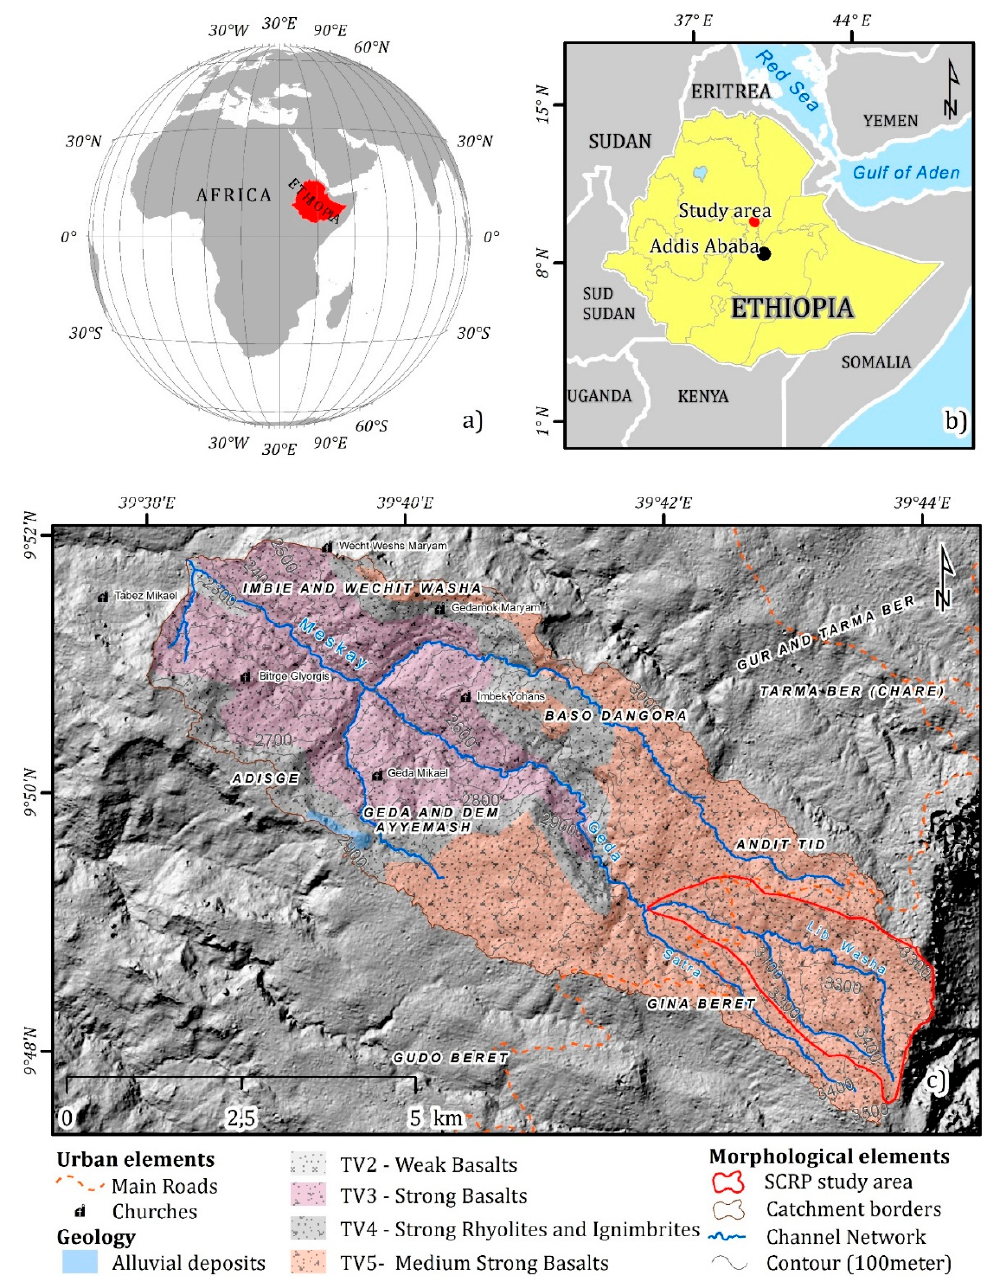
Figure 1. Location of the study area: ( a ) Location of the study area in the African continent; ( b ) Location of the study area in the Ethiopian territory; ( c ) Andit-Tid bedrock lithotypes and main elements of the study area.